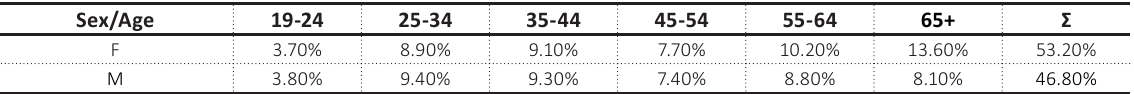
Table 2. Operationalization of consumer storytelling